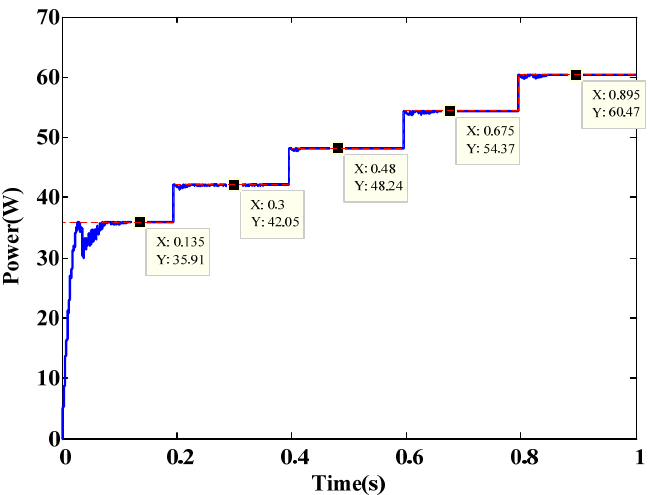
Figure 22. Variable Δ Δ P I  power tracking results